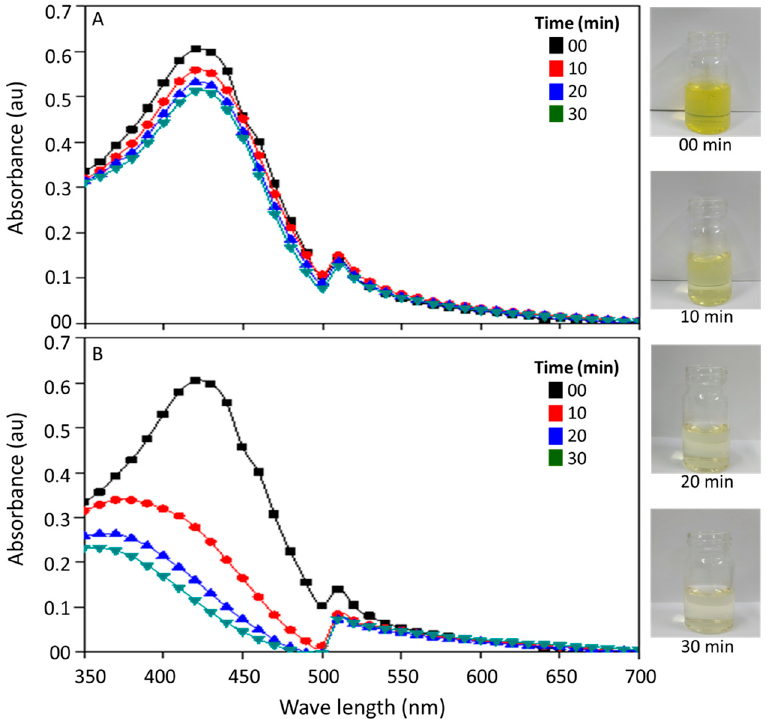
Figure 1. Changes in the absorption spectra of curcumin at different time intervals on exposure to dark ( A ) and light ( B ). The images of curcumin solution at different time intervals of photoexcitation are also given on the right side.